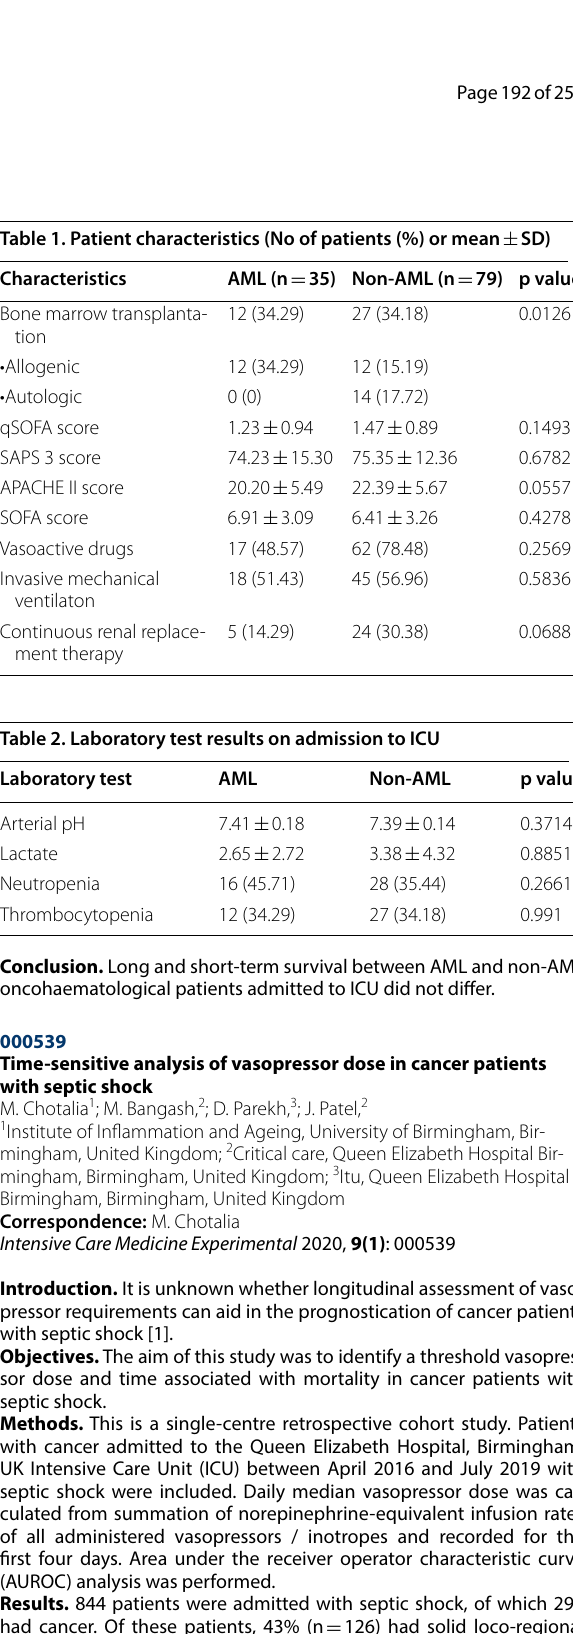
Table 1. Patient characteristics (No of patients (%) or mean Characteristics